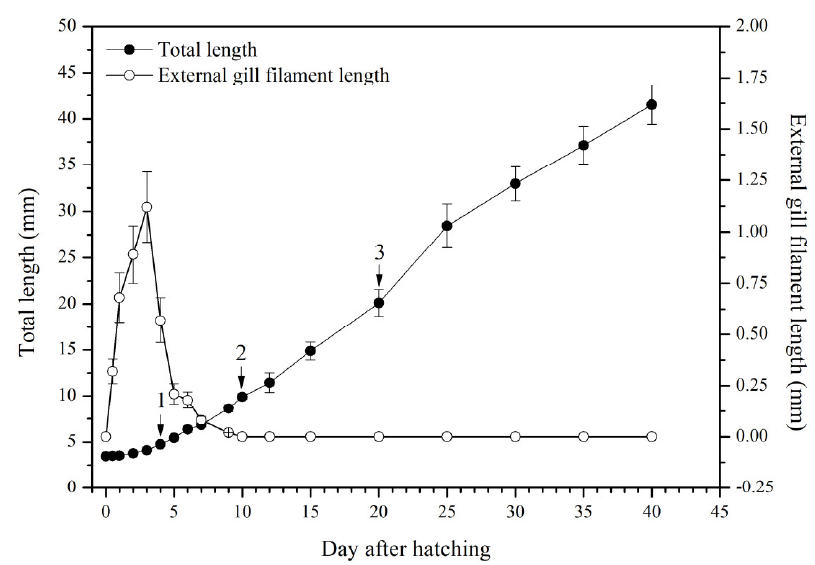
Figure 1. Total length and external gill filament length of P. dabryanus larvae and juveniles during the experiment. ‘1’: first fed Artemia nauplii; ‘2’: fed mixed bait ( Artemia nauplii and Chironomidae larvae); ‘3’: fed a microparticulate diet.